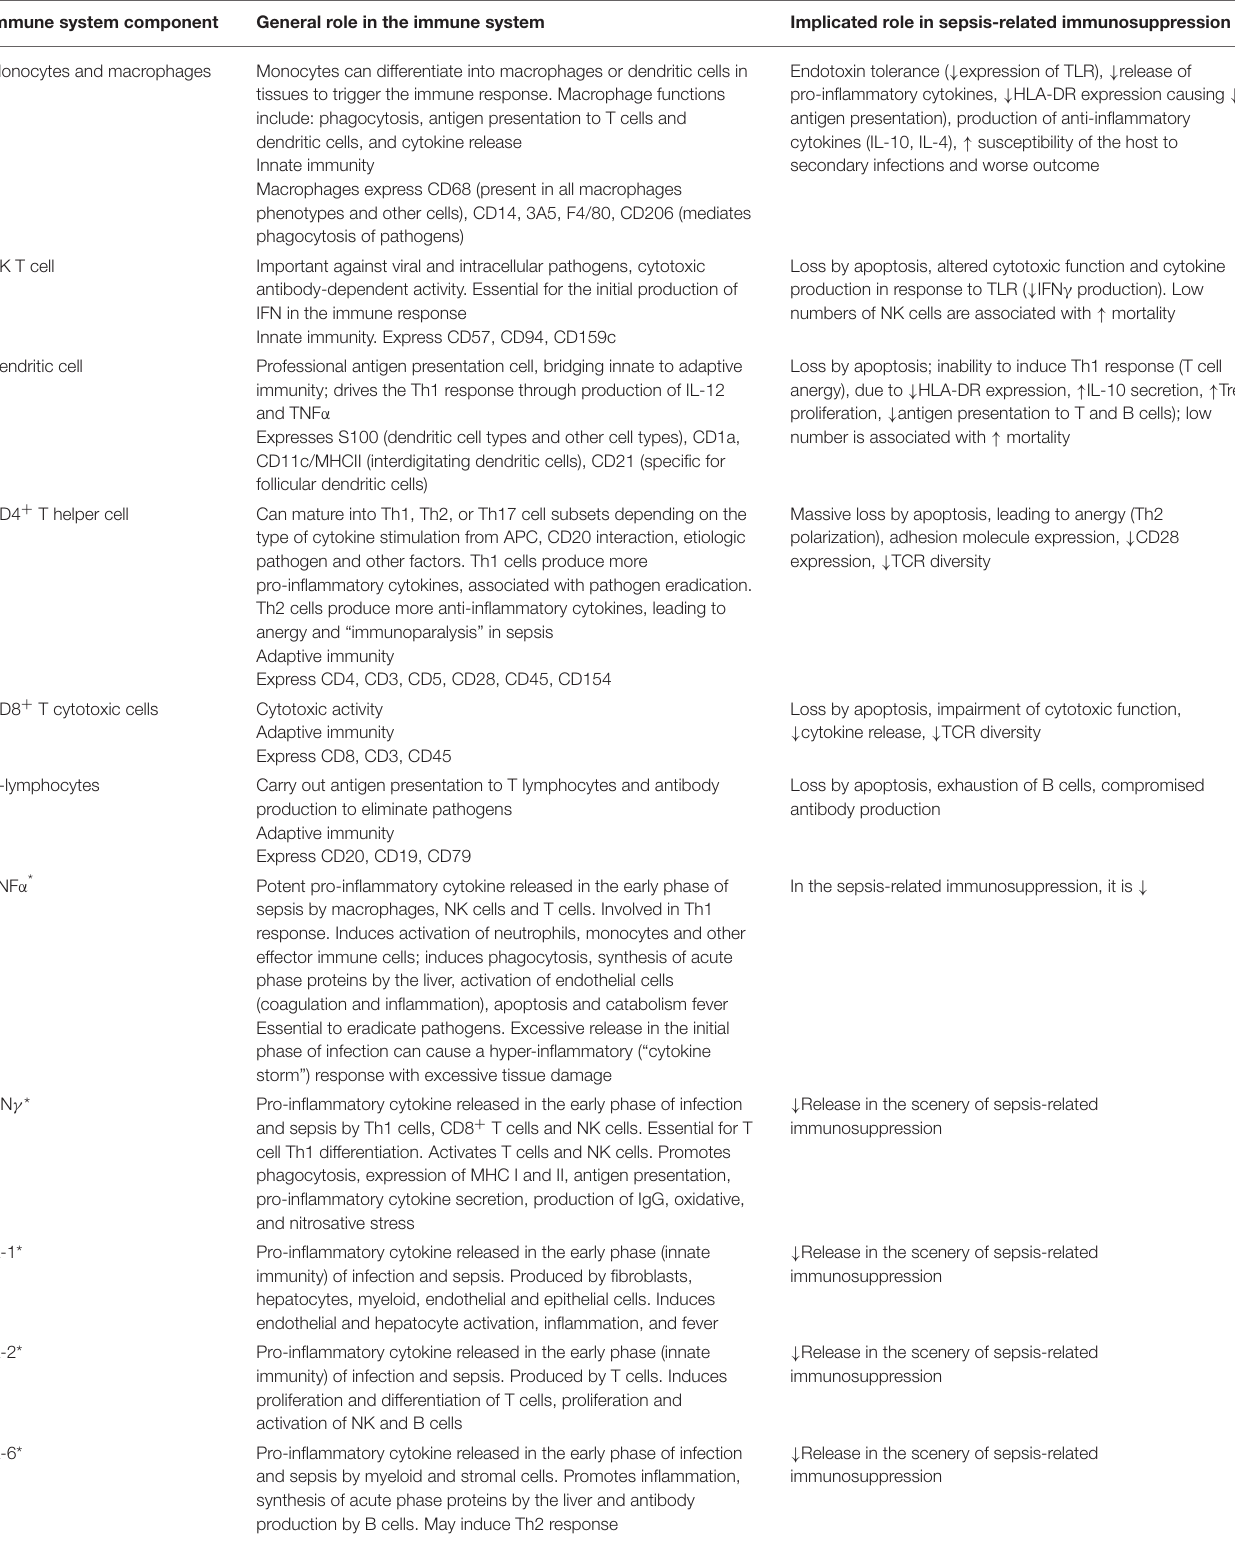
TABLE 1 | Main components of the immune system associated with sepsis and the molecular markers that identify them. Immune system component General role in the immune system Monocytes and